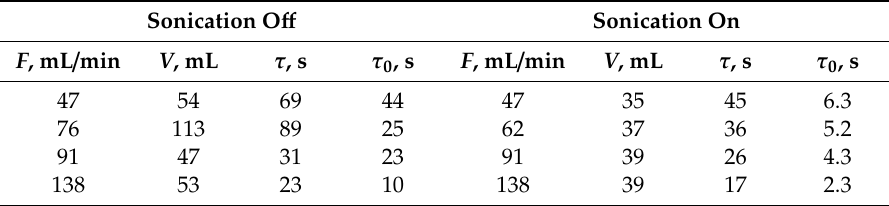
Table 1. Results of tracer pulse experiments for sonication on/off. 115 Sonication O